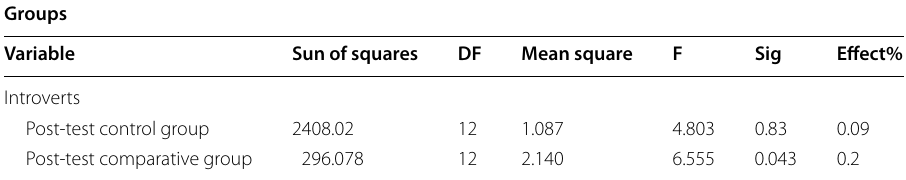
Table 7 ANCOVA on the post-test scores of introvert learners in the comparative and the control Groups